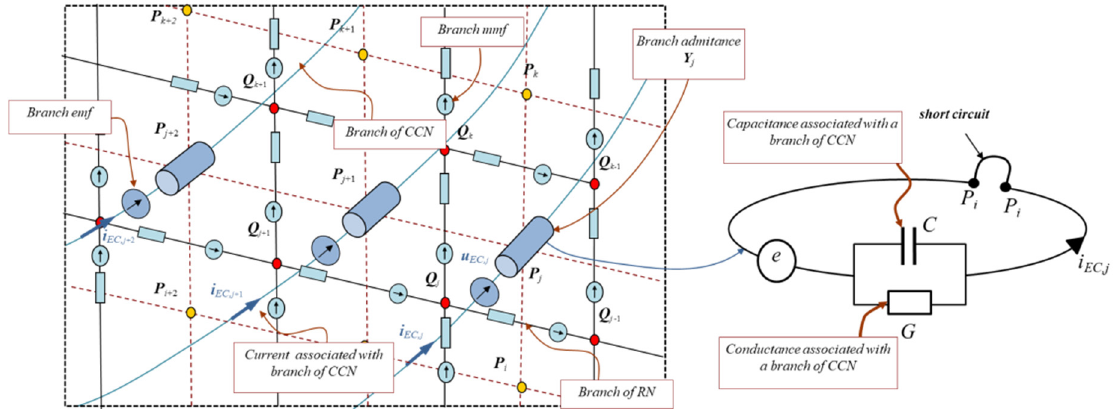
Figure 5. Fragment of the 2D Reluctance Network (RN) coupled with the 1D Conductive-Capacitive Network (CCN).